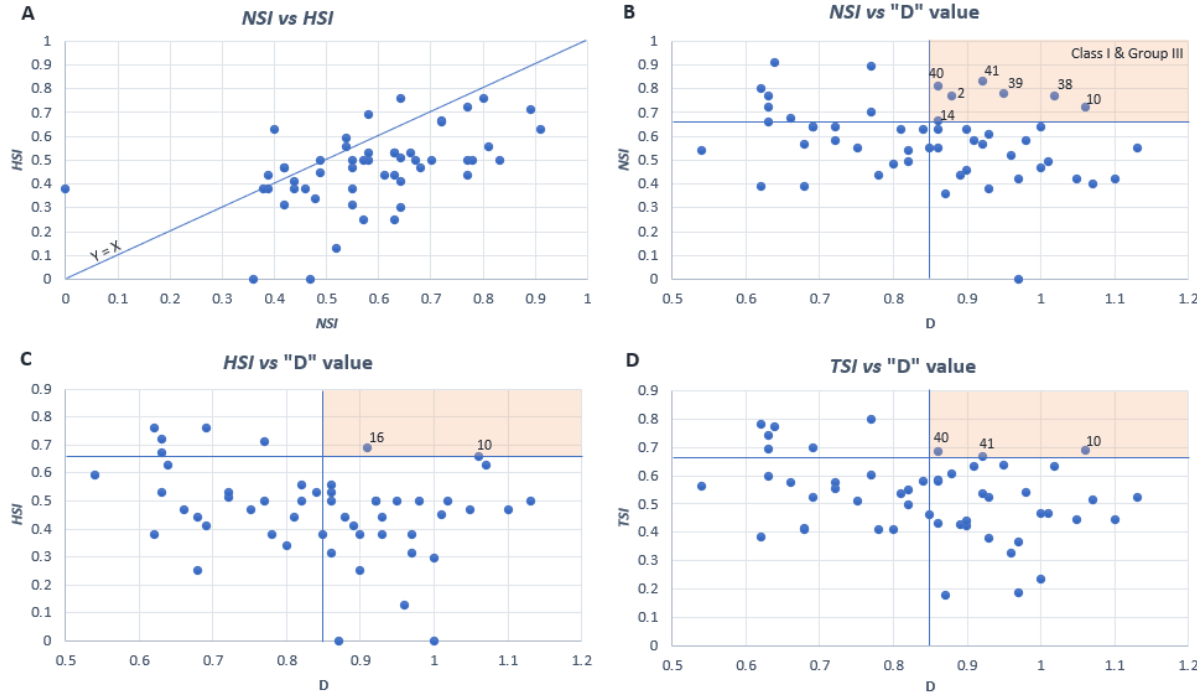
Figure 13. Natural SI versus human SI ( A ), NSI versus “D” value (CSES) ( B ), HSI versus “D” value ( C ) and TSI versus “D” value ( D ). Limits were determined in relation to class I (D ≥ 0.85, CSES) and group III (SI ≥ 0.66, CSSI) and numbers established according to the location map.